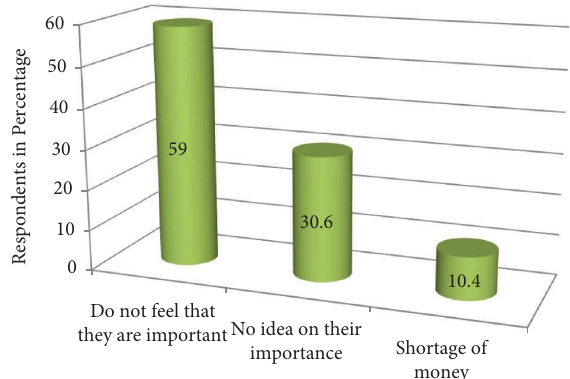
Figure 4: Reasons why the respondents were not using protective cloths.